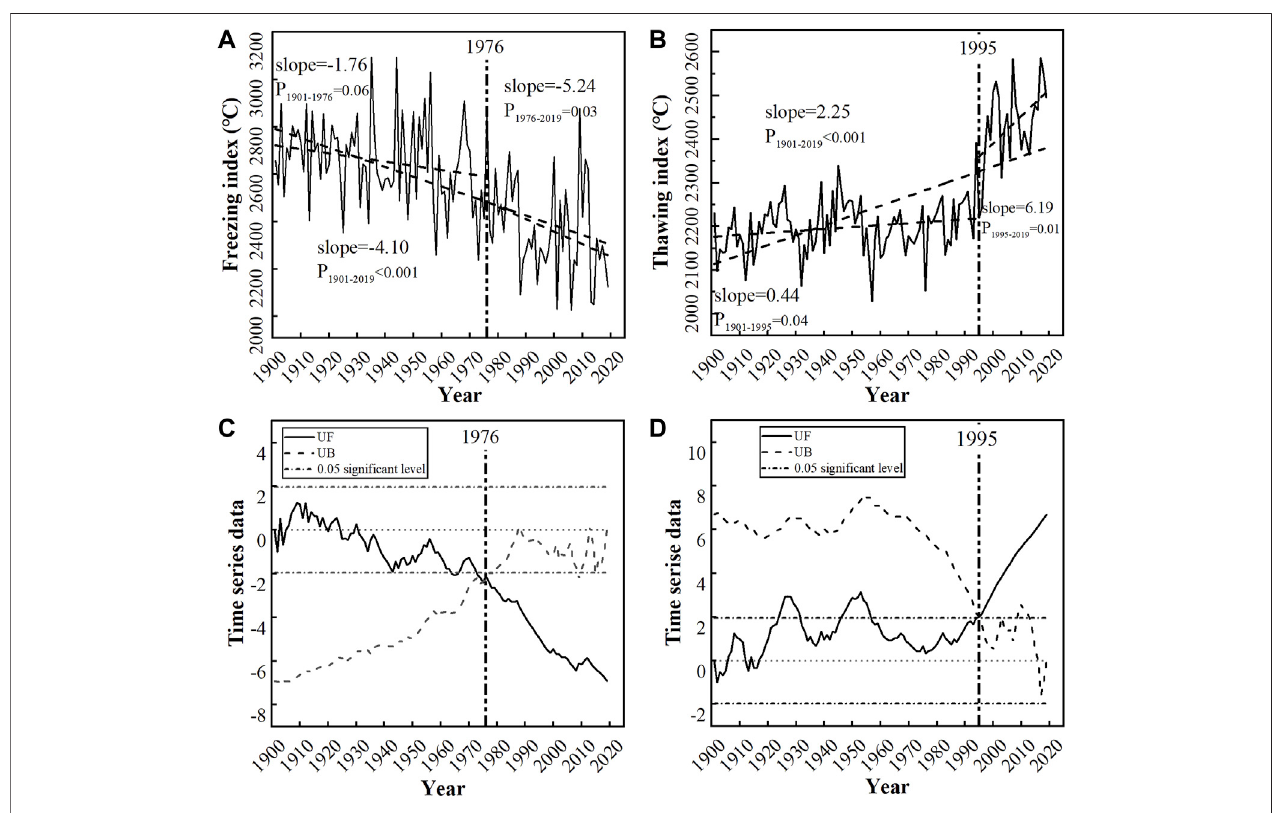
FIGURE5 | Interannual variation in the freezing (A) and thawing (B) index and the change point ofthe freezing (C) and thawing (D) index from 1901 to2019 on the Mongolian Plateau.